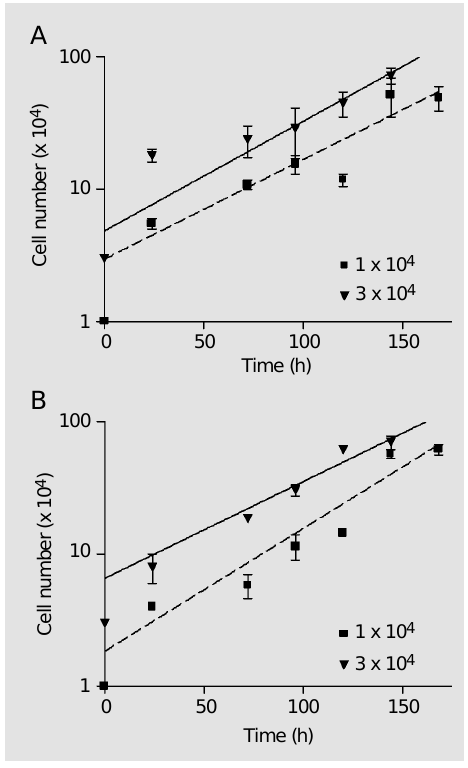
Figure 2. Growth curves of LISP-A10 (A) and LISP-E11 (B) clones. Cells (1 x 10 4 or 3 x 10 4 ) were plated on day 0 and growth curves were generated by counting vi- able cells every 24 h in 24-well culture plates. Popula- tion growth rates were calculated from these